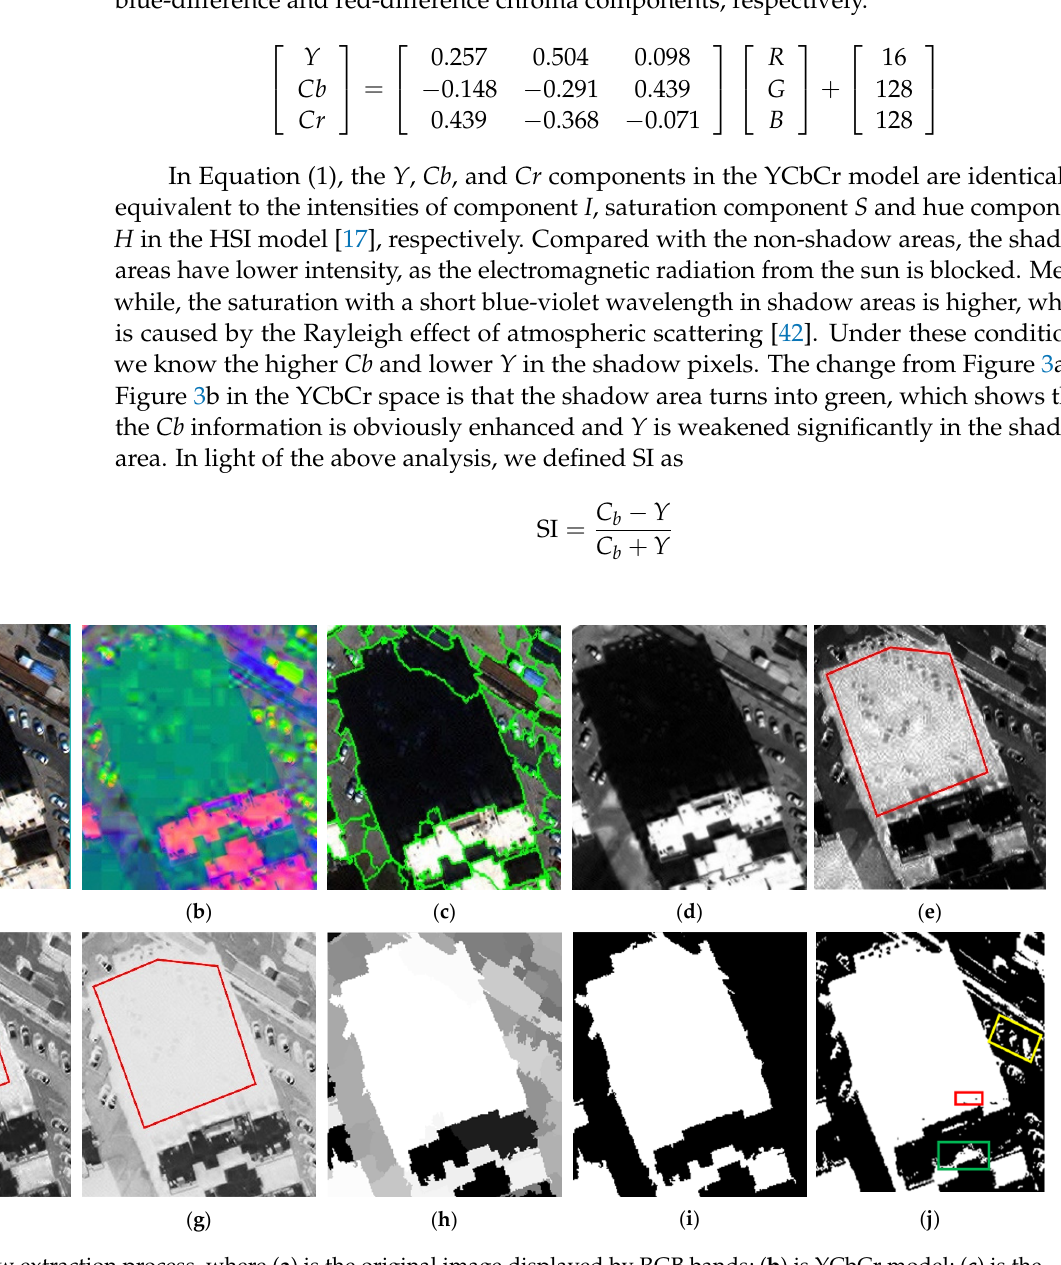
T ; ( f ) is the result of SI; YCbCr